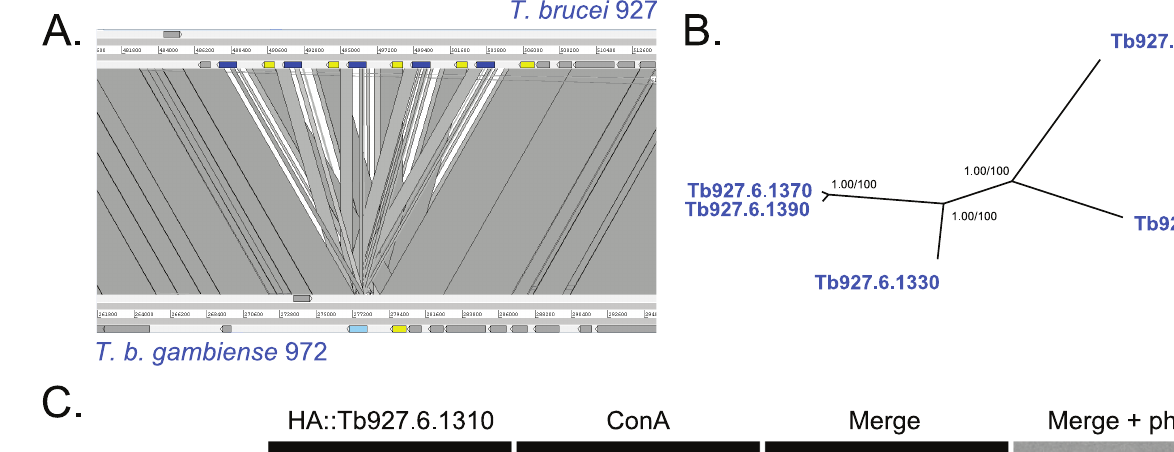
Figure 5. Bayesian phylogeny of adenylate cyclase genes from African trypanosomes (Fam51). The phylogeny was estimated from an amino acid sequence alignment of 1239 characters including all adenylate cyclase proteins from T. brucei 927, T. congolense IL3000 and T. vivax Y486, as well as ESAG4 sensu stricto from T. brucei 927, 427 and T. b. gambiense 972. A mixed amino acid substitution strategy was applied with default settings using MrBayes v3.2.1. The phylogeny is rooted using an outgroup of selected T. cruzi homologs that represent total diversity. Bayesian posterior probability/non-parametric bootstrap values are provided for selected nodes. Black arrows denote the positions of previously named ‘ GRESAG4 ’ sequences, as well as an ESAG4 -like cDNA from T. congolense (Z67964; [85]).